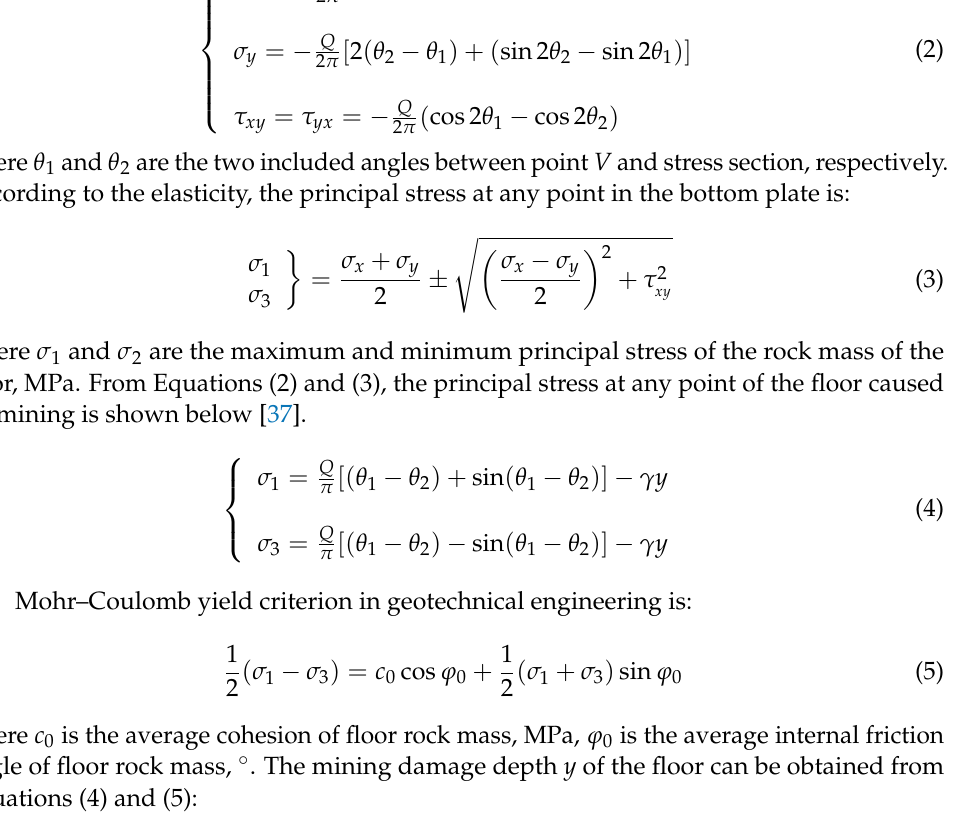
where c 0 is the average cohesion of floor rock mass, MPa, φ 0 is the average internal friction angle of floor rock mass, °. The mining damage depth y of the floor can be obtained from Equations (4) and (5):